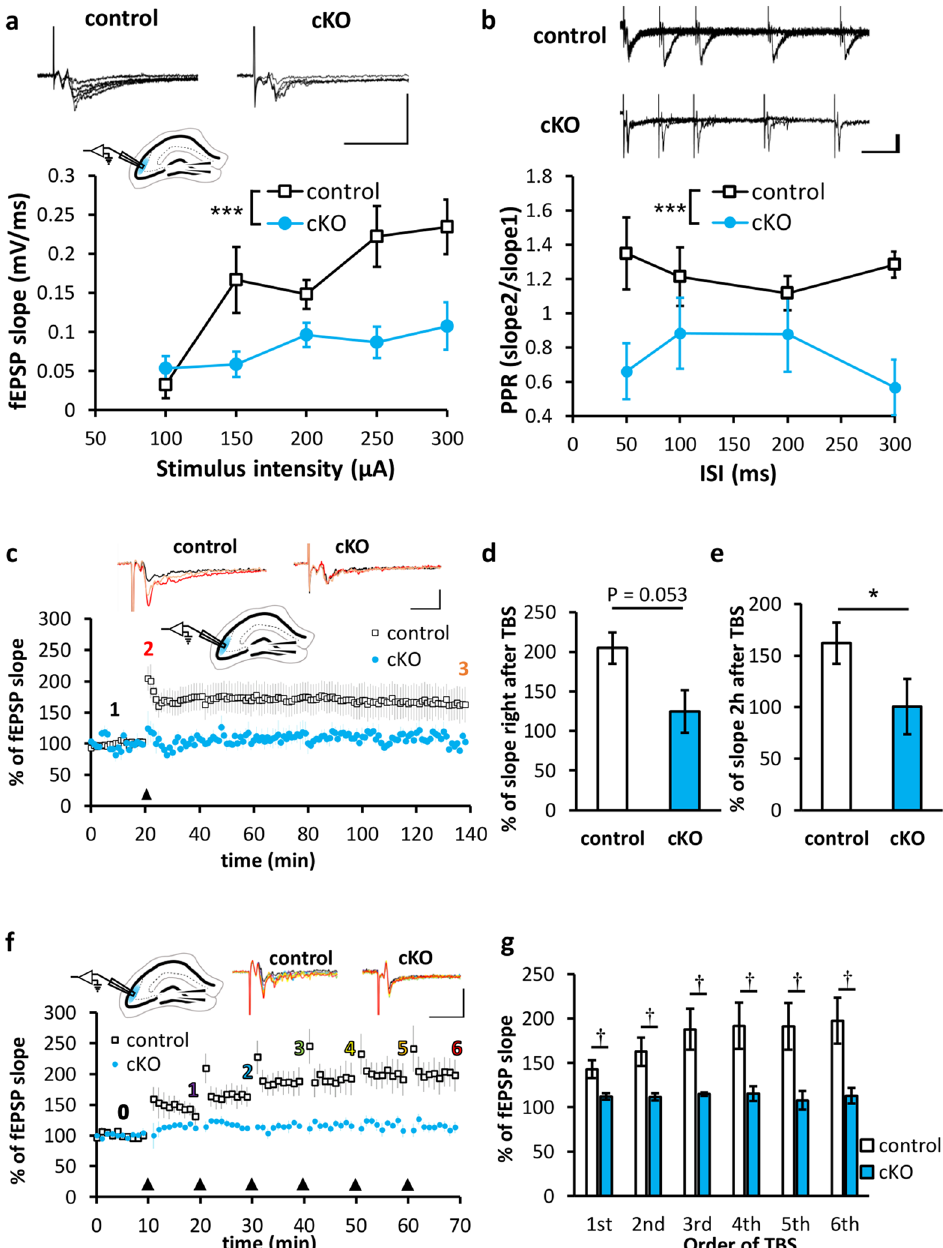
Figure 5. LTP pattern in the CA3 region of Caps1 cKO hippocampal slices. ( a ) Input–output curve of synaptic transmission in the CA3 region. Representative waveforms are depicted in the upper panel (vertical, 500 µV; horizontal, 20 ms). The graph in the lower panel shows the fEPSP slope of electrical stimulation intensity. Control, n = 5 animals; Casp1 cKO, n = 7 animals; *** P < 0.001, repeated two-way ANOVA (Genotype; F (1, 10) = 24.88, P < 0.001). ( b ) Paired-pulse ratio (PPR) recorded from the CA3 region. Representative waveforms are depicted in the upper panel (vertical, 100 µV; horizontal, 50 ms). The graph in the lower panel shows PPRs calculated by dividing the second fEPSP slope by the first fEPSP slope to interstimulus intervals. Control, n = 5 animals; Casp1 cKO, n = 7 animals; *** P < 0.001, repeated two-way ANOVA (Genotype; F (1, 10) = 24.47, P < 0.001) ( c ) Changes in fEPSP slope during LTP induced by TBS in the CA3 region (ratio to the baseline). TBS was applied at the 20 min point (indicated by the black triangle). Representative waveforms recorded at the baseline (black, 1), immediately after TBS (red, 2), and 2 h after TBS (orange, 3) are shown in the top panel (vertical, 200 µV; horizontal, 10 ms). ( d ) Potentiated fEPSP slope levels recorded immediately after TBS in the CA3 region. Control, n = 5 animals; Casp1 cKO, n = 7 animals; P = 0.053, Student’s t -test. ( e ) Potentiated fEPSP slope levels at 2 h after TBS. Control, n = 5 animals; Casp1 cKO, n = 7 animals; P = 0.023, Student’s t -test. ( f ) Changes in fEPSP slope during LTP induced by repeated TBS at 10 min intervals. TBS was applied at the 10, 20, 30, 40, 50, and 60 min points (indicated by black triangles). The representative waveforms recorded at the baseline (black, 0) and with sustained levels induced by the 1st TBS (purple, 1), 2nd TBS (light blue, 3), 3rd TBS (light green, 3), 4th TBS (yellow, 4), 5th TBS (orange, 5), and 6th TBS (red, 6) are shown in the top panel. Scale bars: vertical, 200 µV; horizontal, 20 ms. (G) Sustained potentiation ratios recorded 10 min after the 1st to the 6th TBS. P < 0.05; control vs. cKO, Student’s t -tests. Number (n) of animals used for statistical analyses in this experiment: n = 6 for control and n = 5 for